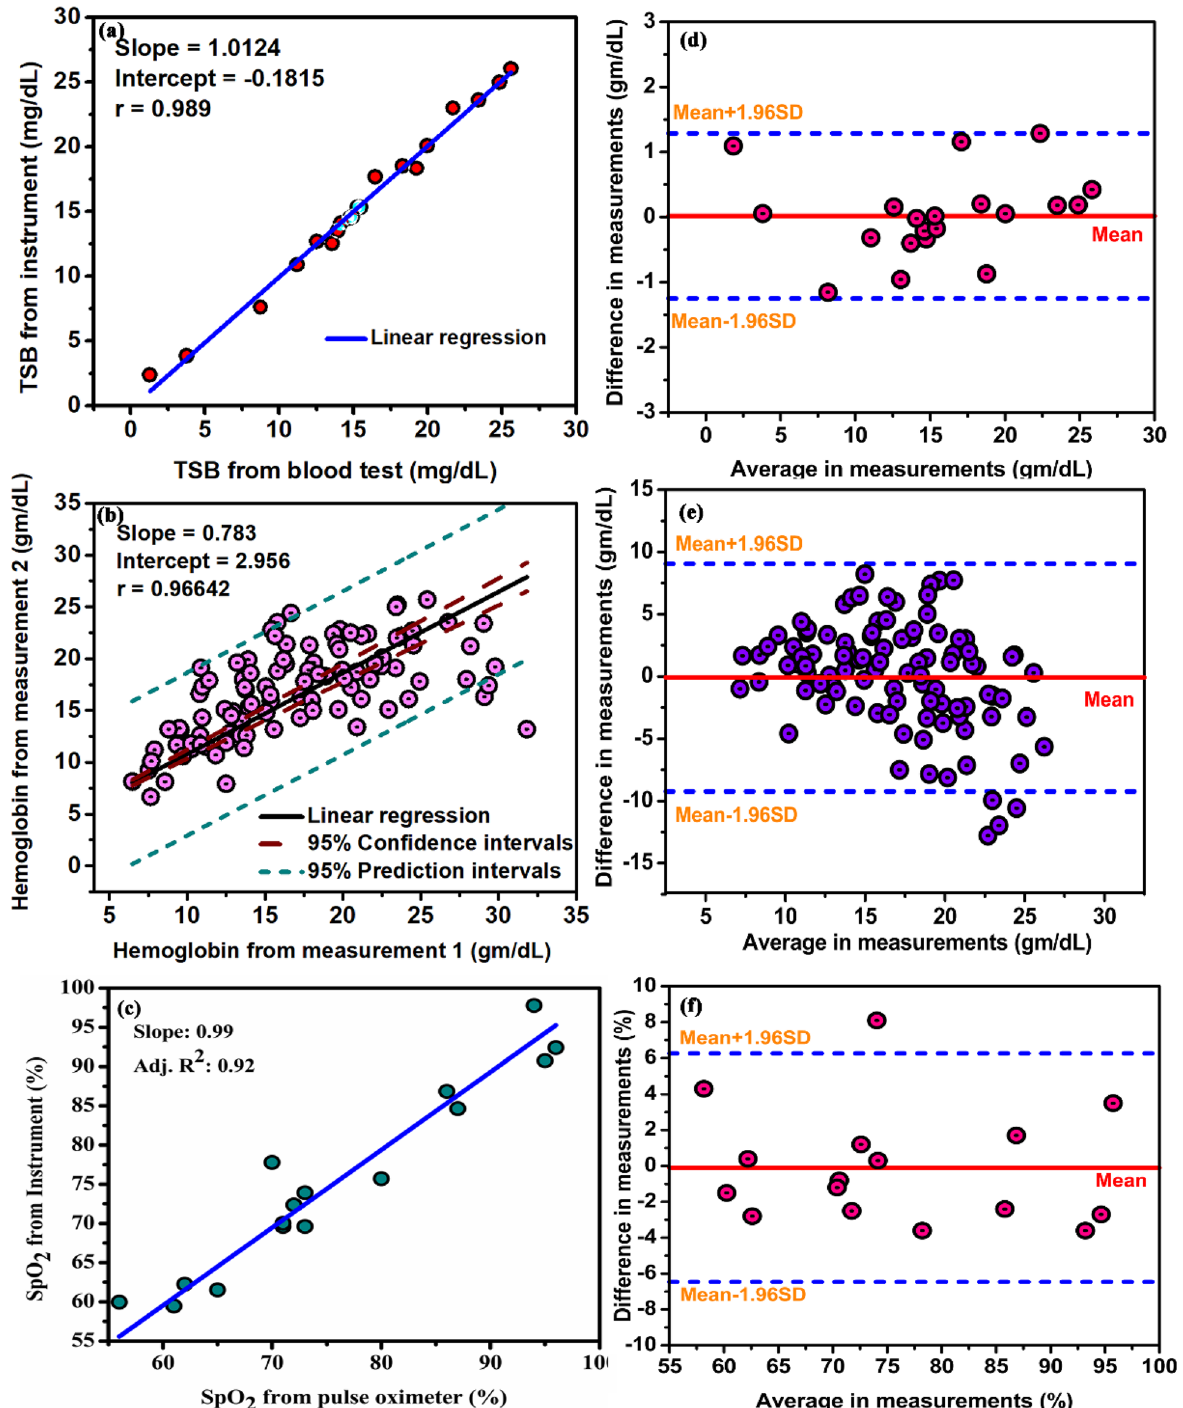
Figure 6. Repeatability of the data acquired using the developed device. Linear Regression analysis for five successive values of ( a ) Bilirubin ( b ) Hemoglobin ( c ) SpO 2 measurement on the same subject by the same observer. Bland–Altman analysis for five successive values of ( d ) Bilirubin ( e ) Hemoglobin ( f ) SpO 2 measurement on the same subject by the same